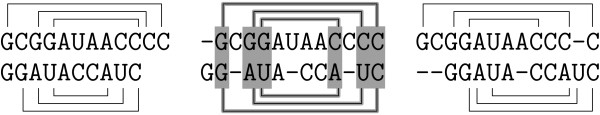
Problem statement. Given the annotated sequences on the left side as the input, we search for an alignment maximizing the sequence plus the induced structure score. The alignment in the middle conserves the entire annotation (highlighted in grey), whereas the alignment on the right hand side maximizes the sequence score and does not conserve any structure.